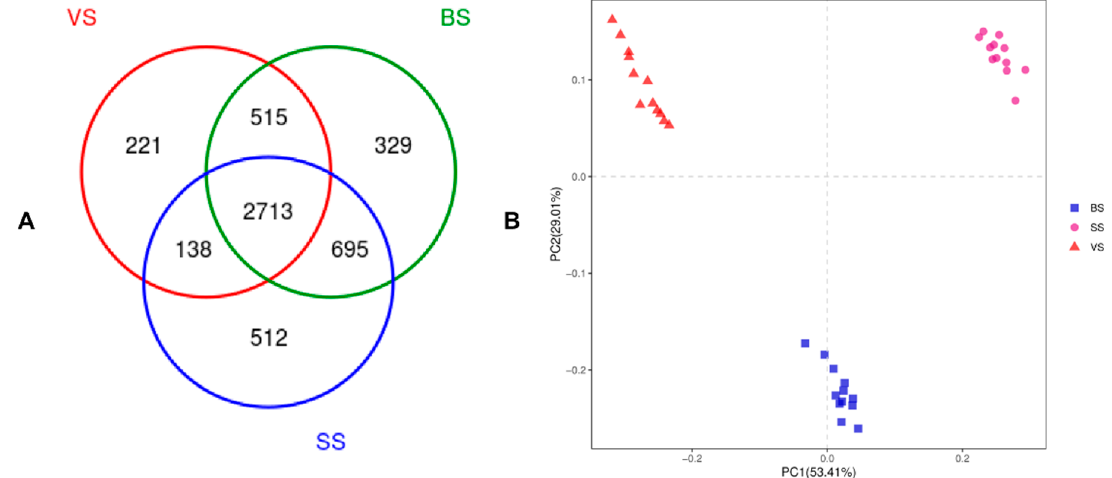
Figure 1. Differences in bacterial community richness and operational taxonomic units (OTUs) in different phenological periods. ( A ): Venn diagram showing the different and similar OTUs in different phenological periods; ( B ): Principal coordinate analysis (PCoA) of the yak ruminal microbiota in different phenological periods. The PCoA plots were constructed using the unweighted Unifrac method. VS: Vegetative stage, BS: Bloom stage, SS: Senescent stage.